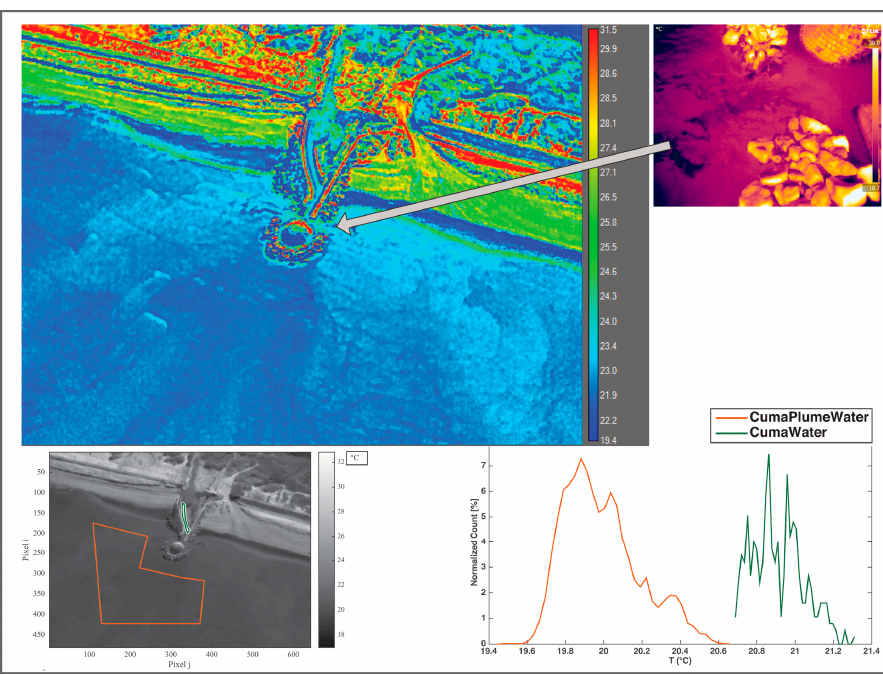
Figure 7. Thermal image of Cuma plume with histogram of radiometric temperature for areas of the channel, seawater, and area of the plume; and (in upper right side) drone-acquired thermal image of the mixing zone in the Cuma channel outlet.